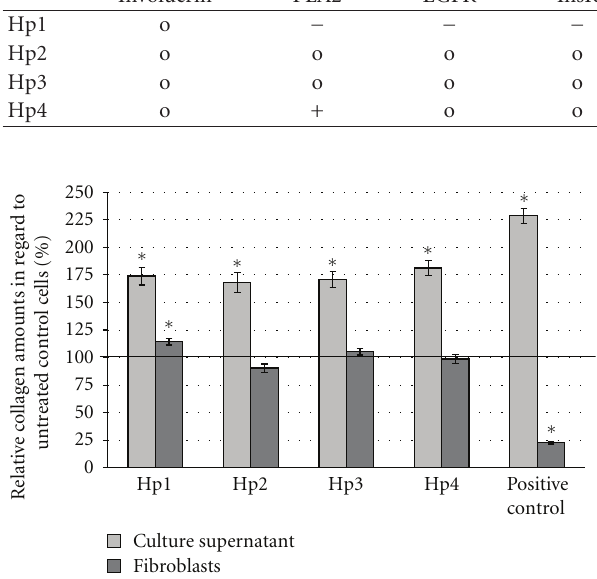
Figure 3: Relative amounts of acid soluble collagen of fibroblast culture supernatants and fibroblasts after incubation with 100 mM L-ascorbic acid as positive control and polysaccharide fractions (10 μ g/mL). Results were indirectly calculated by determination of hydroxyproline with Direct Red 80. Values shown are normalized to collagen amounts in supernatants and cells of untreated control (—: untreated control = 100%). ∗ P < 0 . 05 compared to untreated cells; n = 4. Error bars = SE. less amounts compared to L-ascorbic-acid-treated NHDF (positive control). The amount of remaining intracellular collagen soluble within acetic acid was significantly increased if NHDFs were incubated with Hp1 but was not altered after incubation with polysaccharide fractions Hp3 and Hp4. Polysaccharides of Hp2 slightly reduced the intracellular acidic collagen amounts (Figure